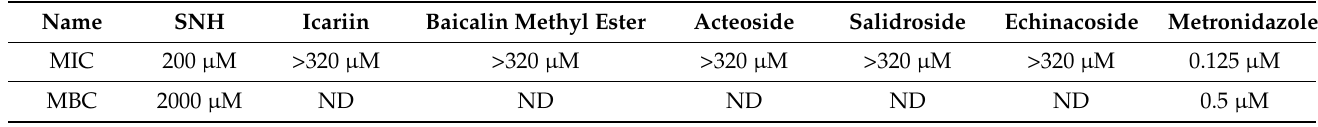
Table 1. MIC and MBC of herbal chemicals against Fusobacterium nucleatum (Fn)